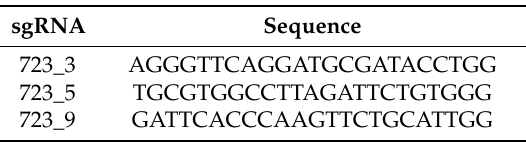
Table 1. MYH7 -specific single guide